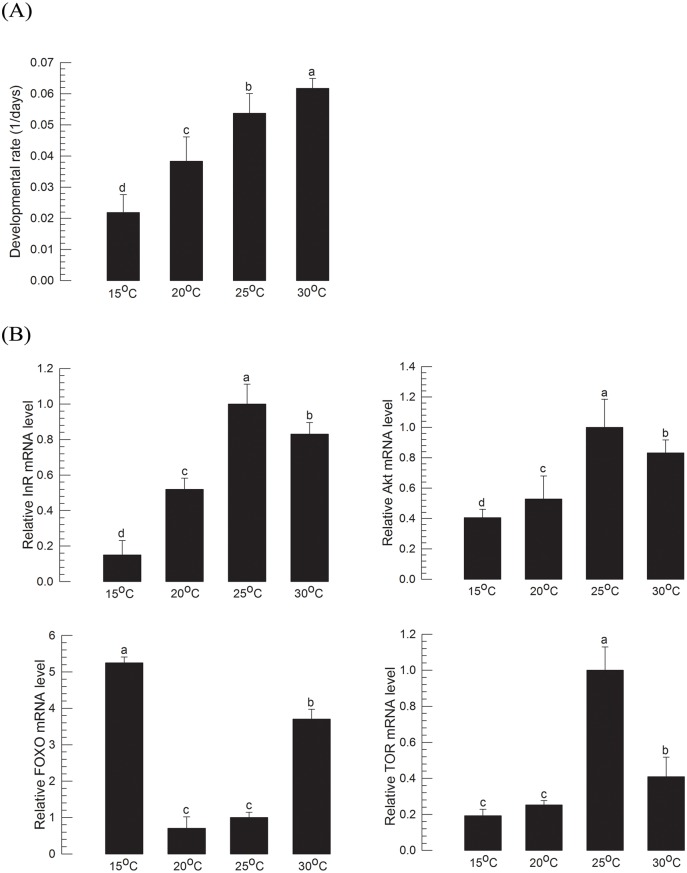
Effect of ambient temperature on larval growth of M. vitrata.(A) Change in developmental rates at four different temperatures. Newly hatched larvae were reared until pupation with an artificial diet. Developmental rate was calculated by inverse of the total larval period (days). Each temperature treatment used 30 larvae. (B) Change in expression levels of four IIS component genes (InR, Akt, FOXO, and TOR). These four genes’ expression levels in L5D1 larvae reared at different temperatures from L1 were quantified. Each treatment used nine randomly selected larvae. mRNA levels were relatively quantified and compared to mRNA levels in L5D1 reared at 25°C. Actin was used as reference gene for RT-qPCR to normalize target gene’s expression level. Different letters above standard deviation bars indicate significant difference among means at Type I error = 0.05 (LSD test).